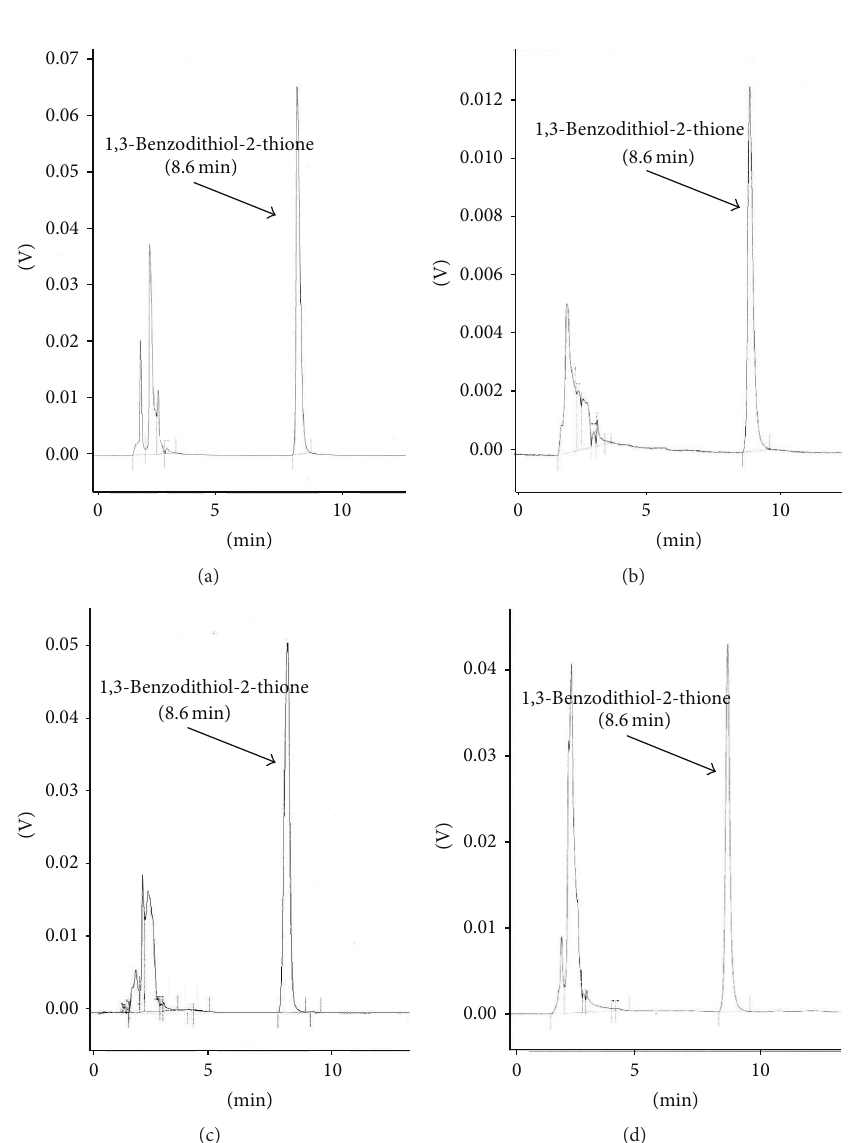
Figure 5: Chromatograms of vegetables extracts after the UAE-HPLC-UV analysis. Broccoli (a), cabbage (b), watercress (c) and cauliflower (d). Characteristic peak of 1,3-benzodithiole-2-thione is shown at 8.6